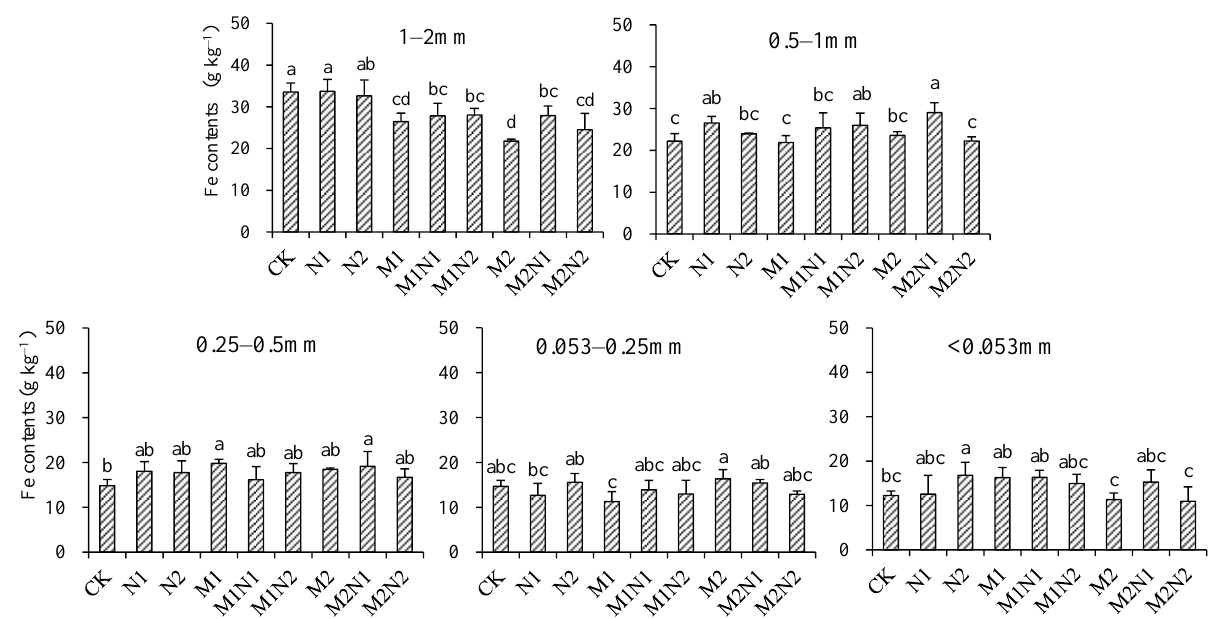
Figure 2. Iron contents in the soil aggregates after 38 – year fertilization with nine treatments. CK: no fertilizer, N1: low nitrogen, N2: high nitrogen, M1: low manure, M1N1: low manure and low nitrogen, M1N2: low manure and high nitrogen, M2: high manure, M2N1: high manure and low nitrogen, M2N2: high manure and high nitrogen. Different lower – case letters denote significant differences between treatments by least – significant difference at the 5% level.